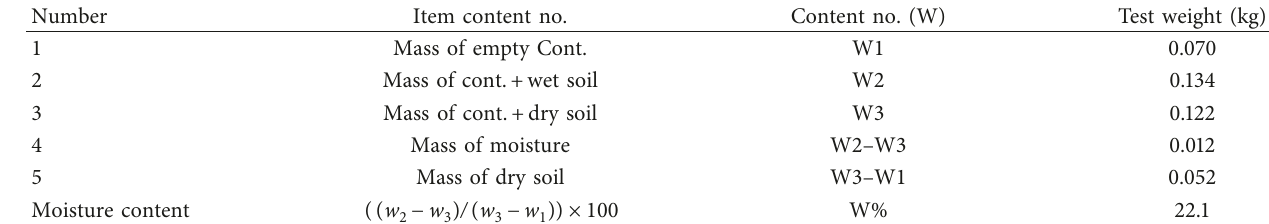
Table 4: Water content test.